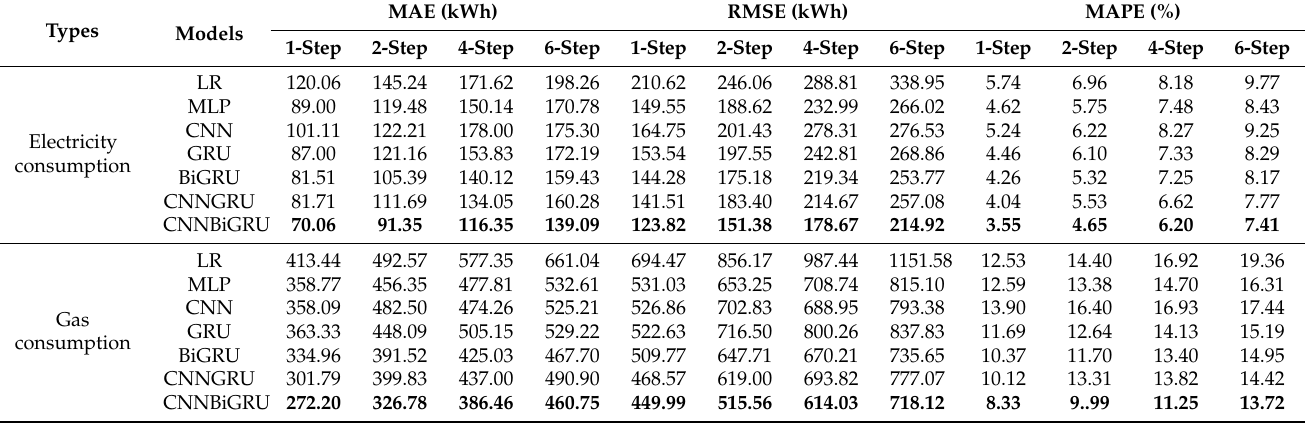
Table 4. Comparison of error evaluation indicators for direct multi-step ahead prediction with different